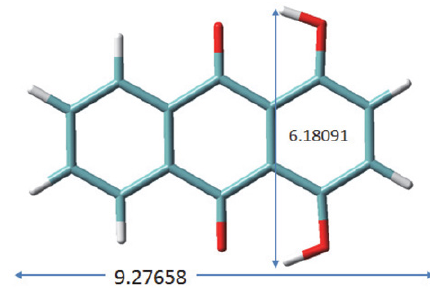
Figure 1. Optimized molecular structure of quinizarin using B3LY- P/6-311G* basis